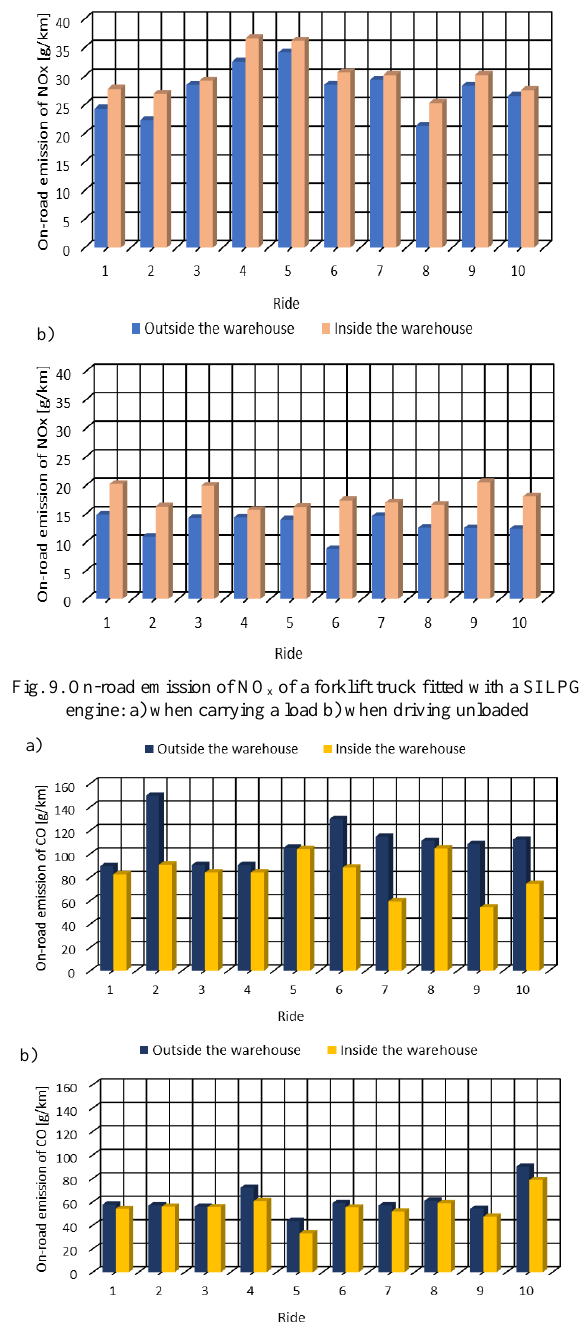
Fig. 10. On-road emission of CO of a forklift truck fitted with a SI LPG engine a) when carrying a load b) when driving